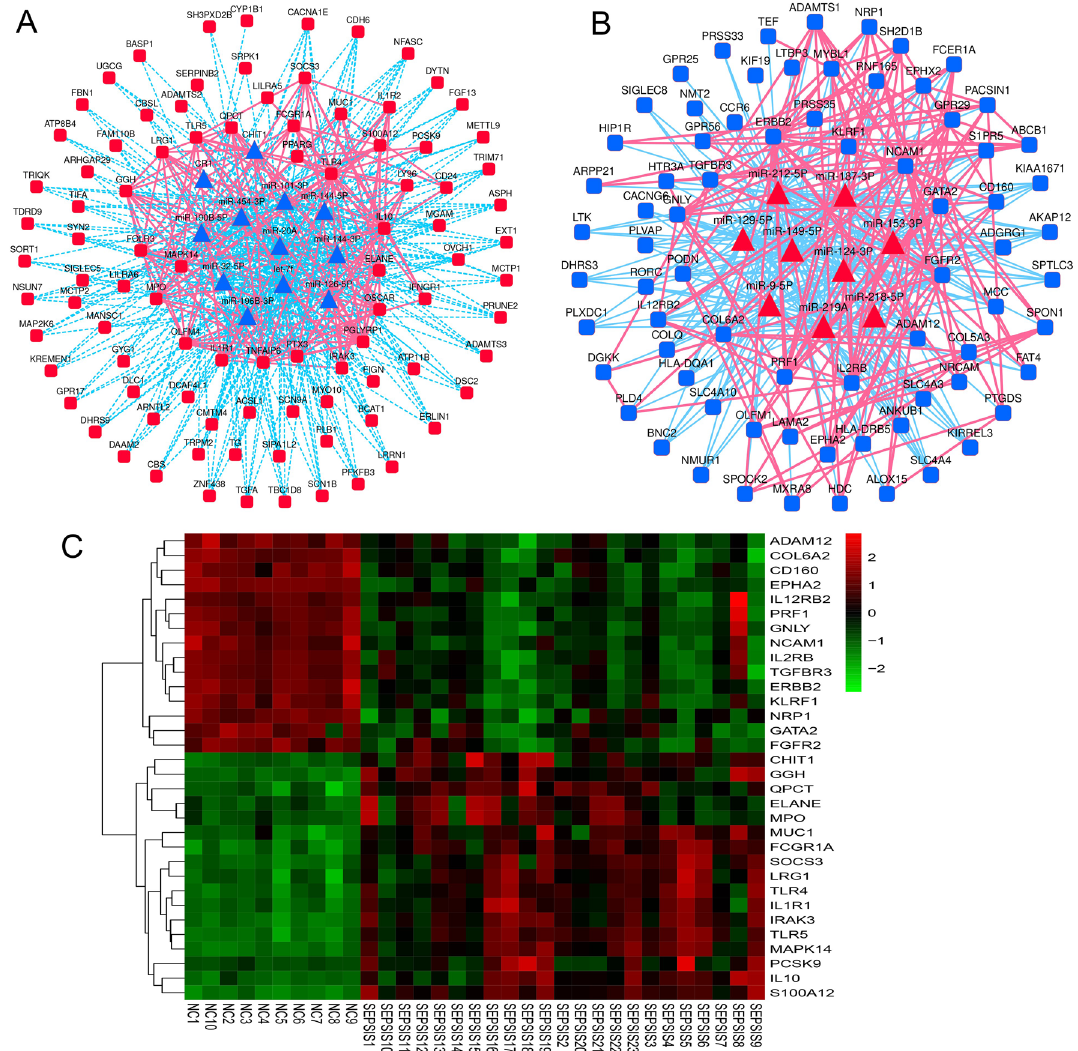
Figure 4. miRNA–mRNA–PPI regulatory network for identification of potential key genes. ( A ) miRNA– mRNA–PPI network of upregulated DEGs and downregulated DEMs. Red squares, upregulated DEGs; red lines, protein–protein interactions; blue triangles, downregulated DEMs; blue lines, miRNA–mRNA interactions. ( B ) miRNA–mRNA–PPI network of downregulated DEGs and upregulated DEMs. Blue squares, upregulated DEGs; red lines, protein–protein interactions; red triangles, downregulated DEMs; blue lines, miRNA–mRNA interactions. ( C ) Heatmap of the 30 potential key genes based on genes located at the centre of the miRNA– mRNA–PPI network. Data from controls are shown in blue and data from septic patients are shown in red. PPI protein–protein interaction, DEMs differentially expressed miRNAs, DEGs differentially expressed genes, NC healthy control